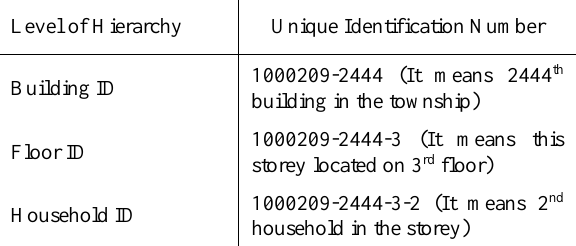
Table 2. Unique identification number of hierarchy